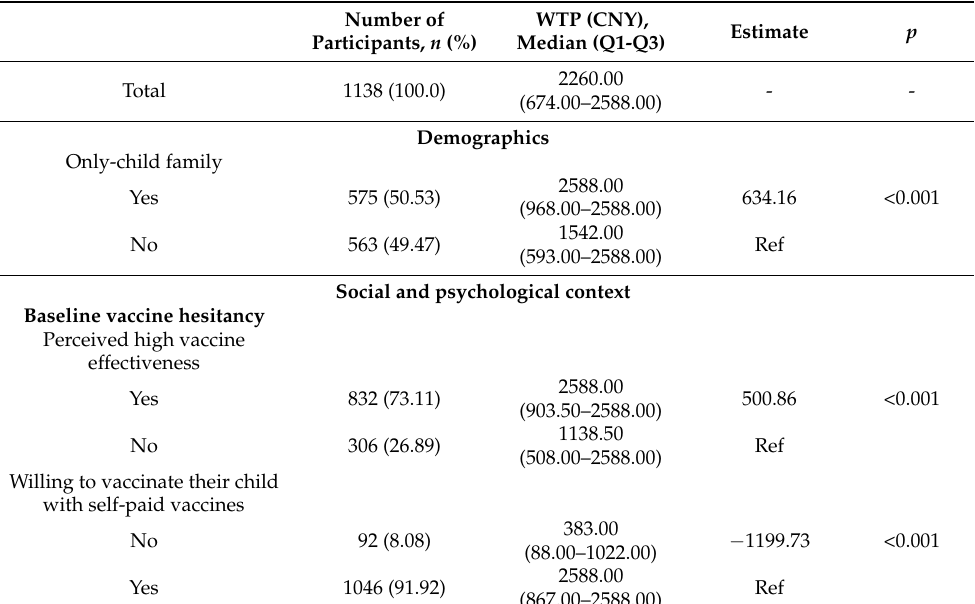
Figure 2. Willingness to pay for 13-valent pneumococcal conjugate vaccines excluding those with vaccine refusal. ( a ) Waterfall plot showing the change of participants’ proportions in different payment schemes. ( b ) Boxplot showing willingness to pay in different payment schemes. Table 3. Drivers for caregivers’ willingness to pay (WTP) to vaccinate children with 13-valent pneumococcal conjugate